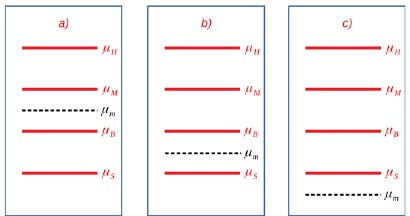
Figure 2: Di ff erent scenarios for various secondary quark masses within the bHQET frame- work. μ m is the scale corresponding to secondary quark mass. The relevant scenario in the case of top (bottom) primary (secondary) quark is b